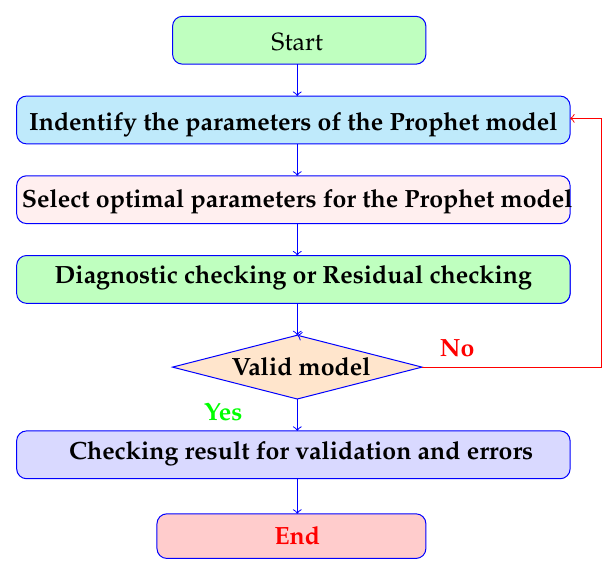
Figure 3. The flow chart of the Prophet